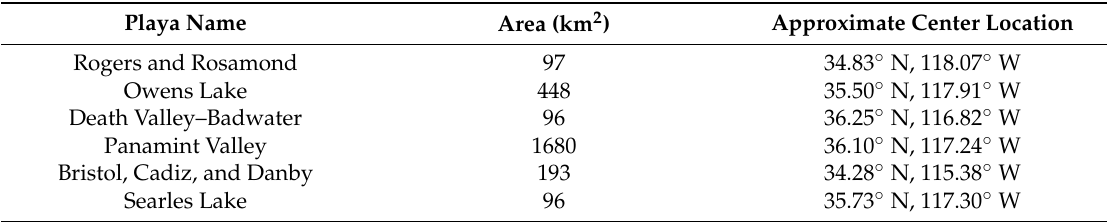
Table 1. Largest dry lakes (playas) in the Mojave Desert region of California [11].